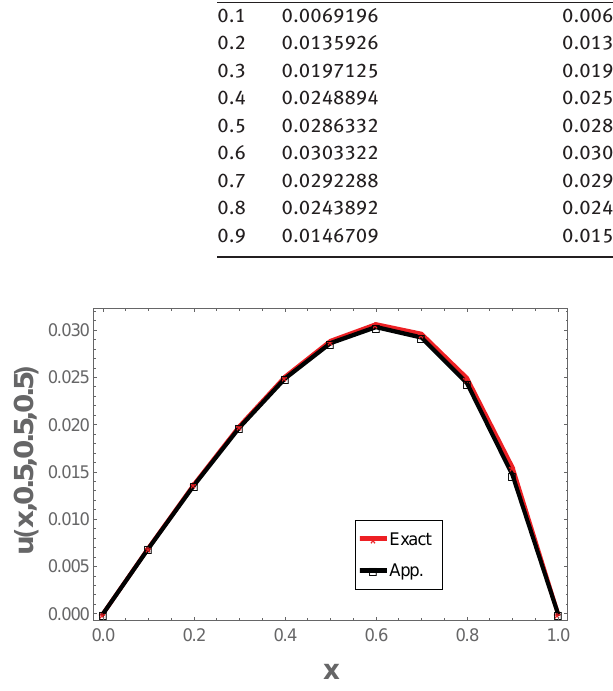
Table 7: The numerical resultes for fourth problem at y = z = d = 0.5, x , y , z , d ∈ [0, 1] x